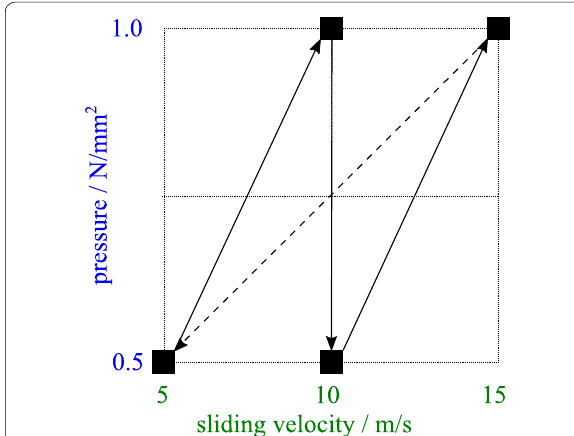
Figure 5 Test method—load levels and sequence of load stages [32]